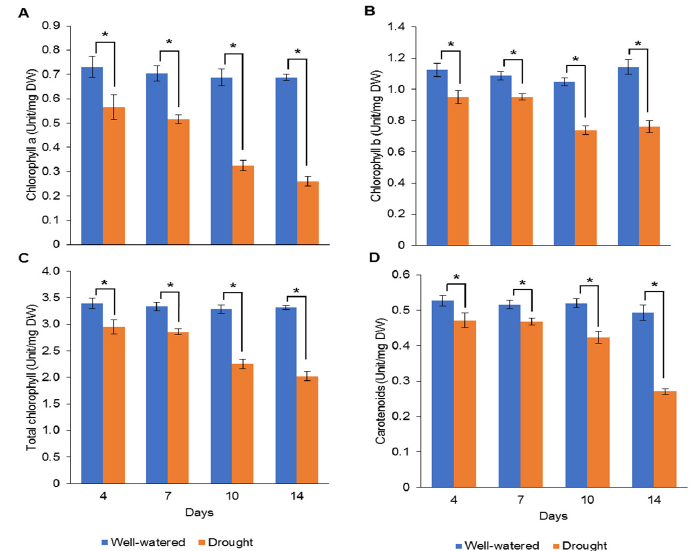
Figure 2. Pigment contents of leaf samples for well-watered and drought-stressed Pandanus amarylli- folius at different timepoints. The concentrations of ( A ) chlorophyll a (U mg − 1 DW), ( B ) chlorophyll b (U mg − 1 DW), ( C ) total chlorophyll (U mg − 1 DW), and ( D ) carotenoid (U mg − 1 DW). Means labeled with asterisk (*) were significantly different based on the Student’s t -test when its p -value < 0.01.